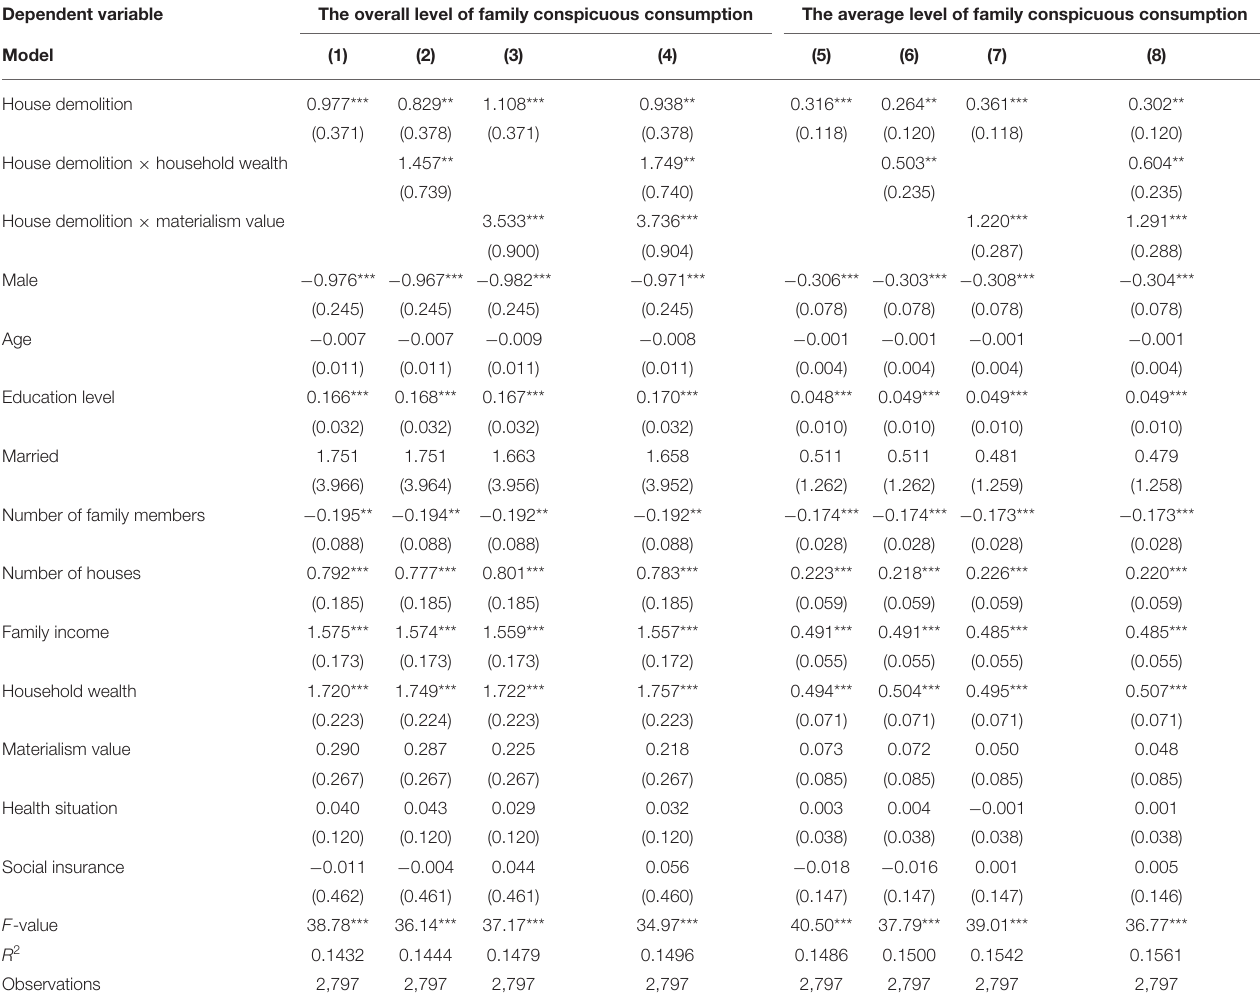
TABLE 2 | Results of house demolition on family conspicuous